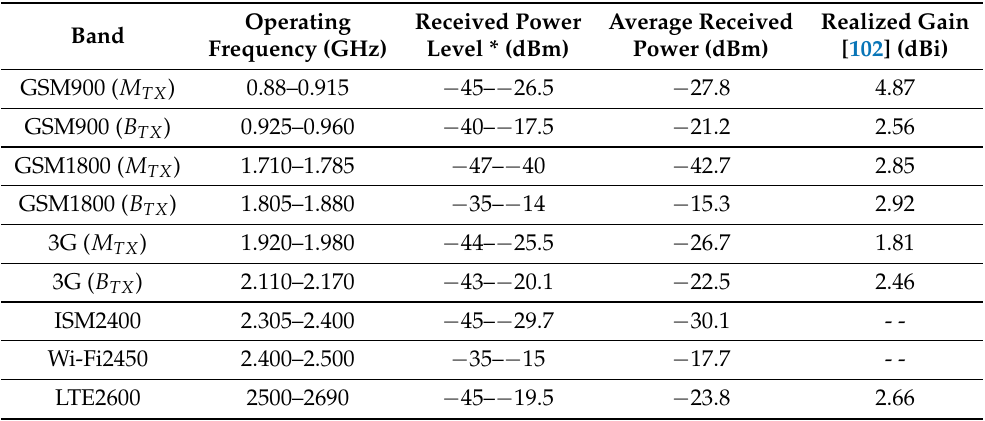
Figure 4. Measured received ambient RF power levels at different locations at Multimedia University, Cyberjaya Campus [76]. Table 2. Received ambient power from various public telecommunication